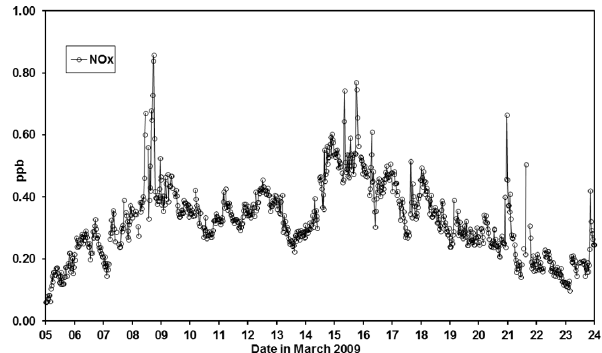
Fig. 3. Atmospheric concentrations of NO x (ppb) at Station Nord measured as half hour mean during the field campaign in March 2009.